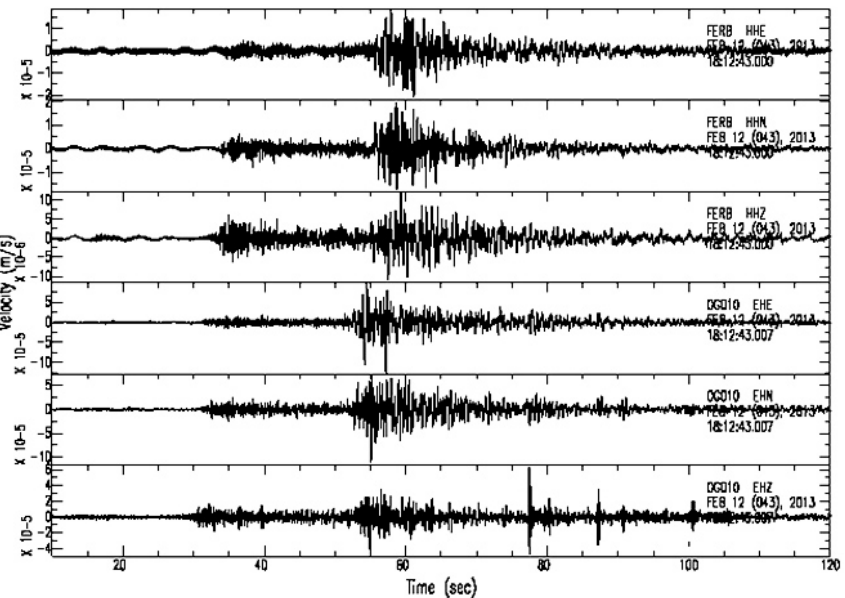
Figure 3. The event of magnitude 3.8 occurred on 12 February 2013 at 18:12:25UTC, in the Carnian Prealps recorded by FERB VBB borehole station (top traces). For comparison, same event recorded by temporary surface station co-located (bottom